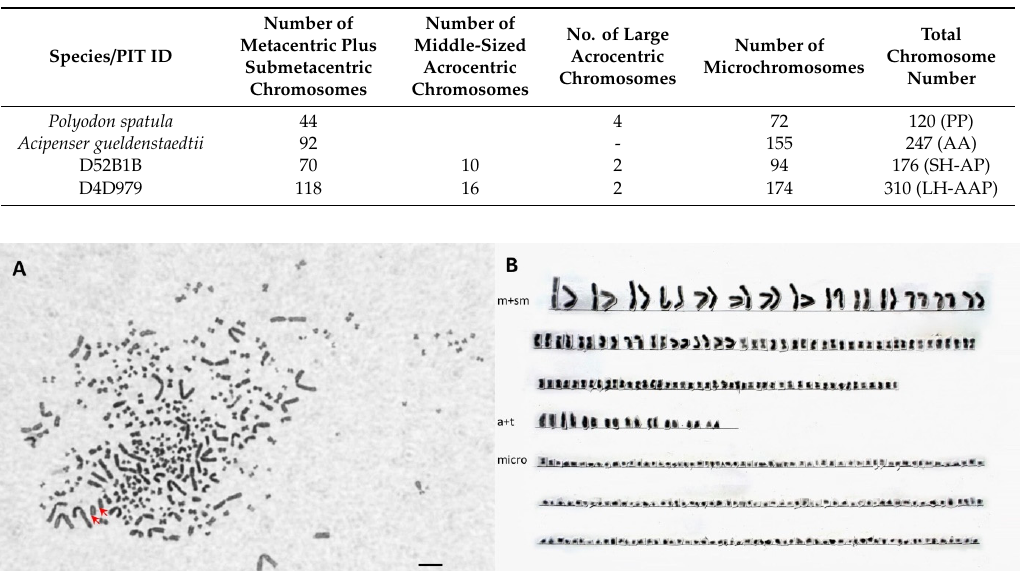
Figure 1. Mitotic metaphase chromosome spread ( A ) from fibroblast cell culture of the pectoral fin of an SH (small genome size hybrids) individual (No. D52B1B). ( B ) Corresponding karyotype of A. gueldenstaedtii × P. spathula triploid hybrid. Red arrows show the paternal-originated two large acrocentric chromosomes from P. spathula . Bar 5 μ m. Table 6. Characteristics of karyotypes of triploid and pentaploid hybrids compared with parental species (based on Birnstein et al.) [3].